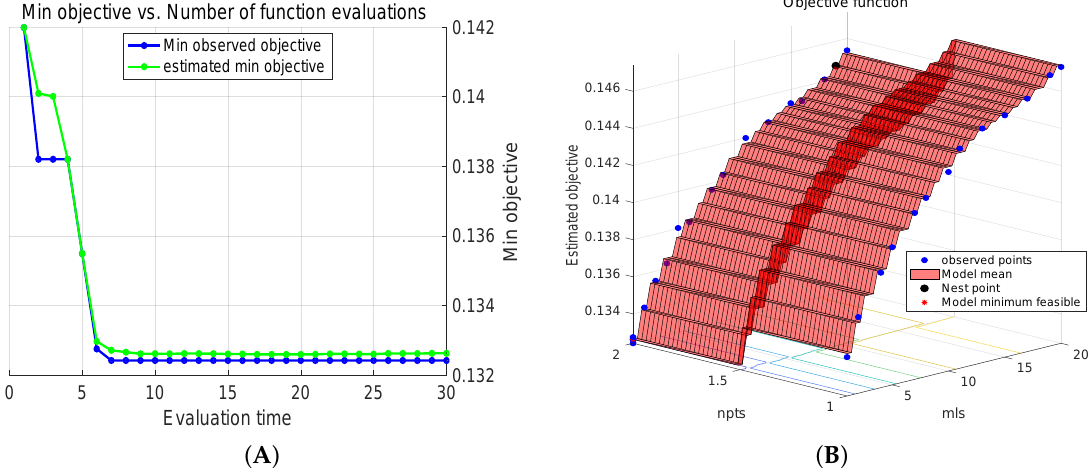
Figure 5. ( A ) Minimum objectives over evaluation time by using RGB features; ( B ) estimated fitness function values over the combinations of npts and mls using RGB